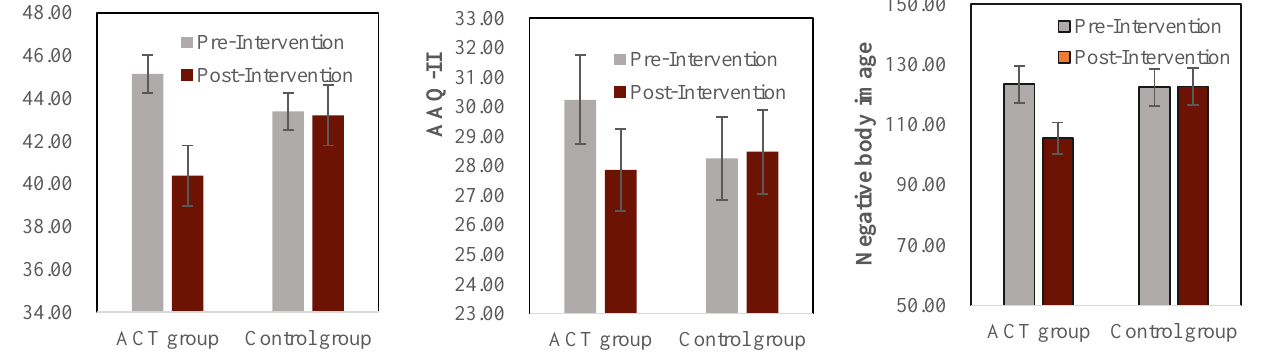
Figure 1. Bar plots for cognitive fusion ( left panel ), higher CFQ score indicates lower levels of cognitive defusion; psychological flexibility ( middle panel ), higher AAQ score indicates lower levels of psychological flexibility; and negative body image index (negative physical self scale, NPSS) ( right panel ), higher NPSS score indicates higher levels of negative body image concern. Not the intervention was applied only to the ACT group.